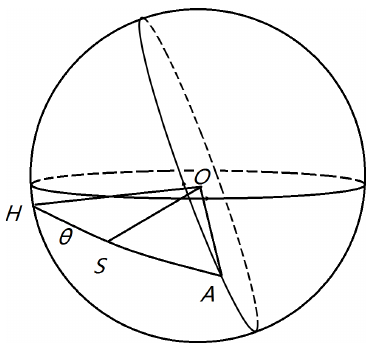
Figure 3. Celestial sphere